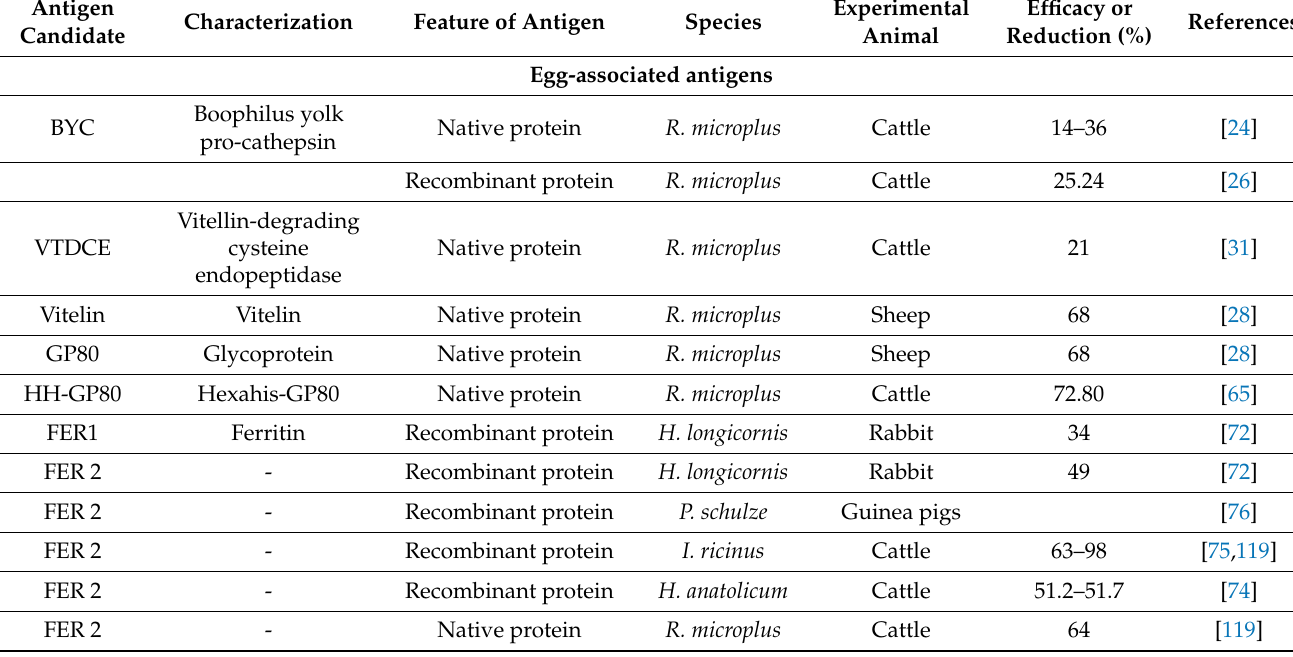
Table 1. List of antigen candidates being studied at the pre-clinical or clinical stages for controlling